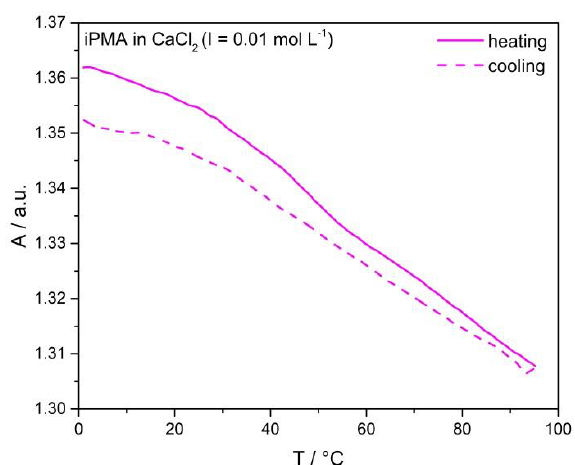
Figure S3. The enlarged plot of the temperature dependence of the UV absorbance ( A ) at 280 nm for iPMA ( c 0.022 mol L -1 , α = 0.20) solution in CaCl N